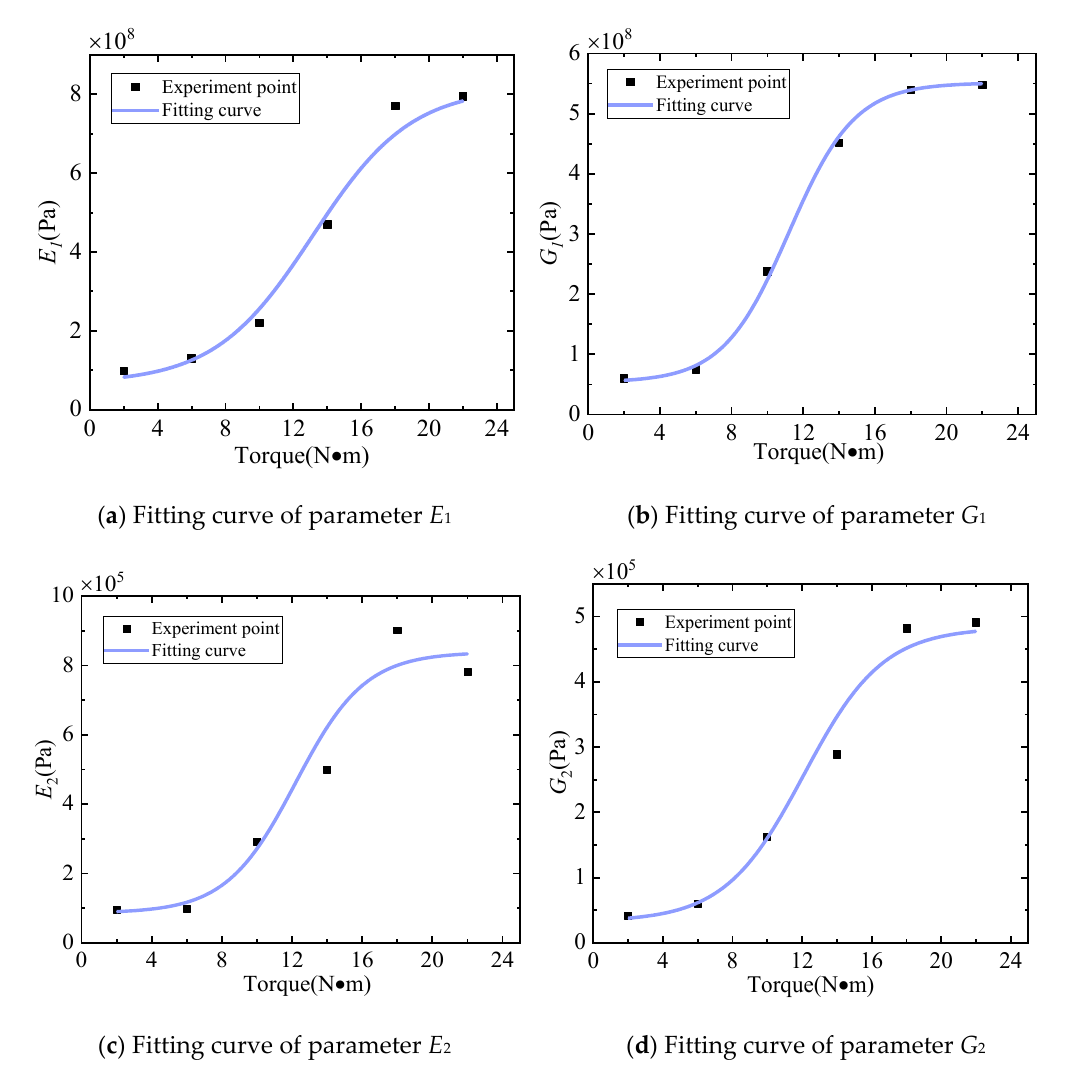
Figure 15. The relation curves of identification parameters change with pre‐tightening torque. In order to verify the correctness of the method, we selected five points evenly in the interval of the fitting curve, obtained E 1 , G 1 , E 2 and G 2 through the parameter identification method, and put these values into the curve for verification. In Figure 16, the red dots are the verification points. It can be seen that the error between the red dots and the fitting curve is small, which proves the effectiveness of the method.